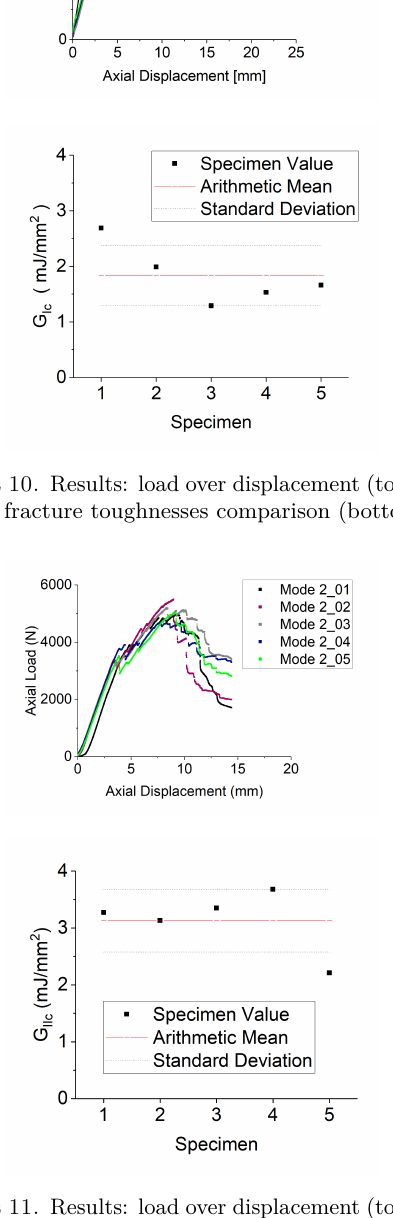
Figure 11. Results: load over displacement (top) and mode II fracture toughnesses comparison